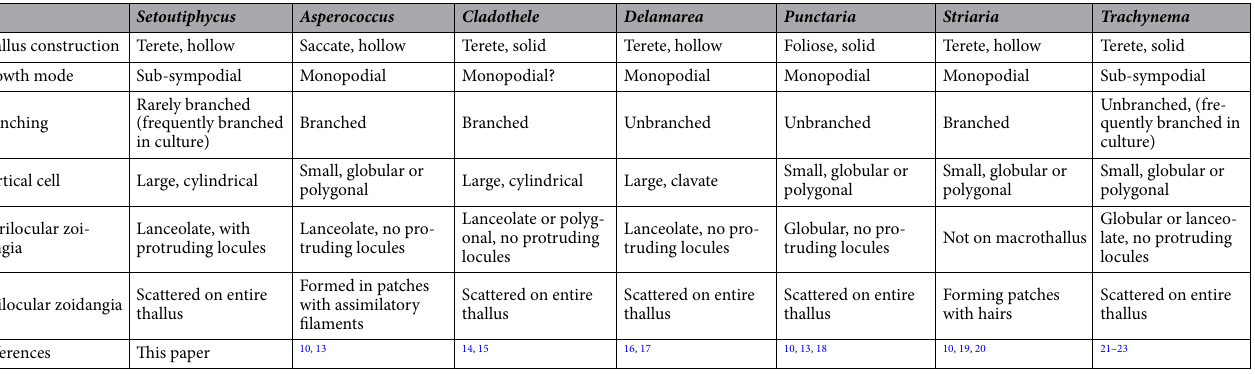
Table 1. Comparisons of representative morphological features between genera in clade 1 in Fig.